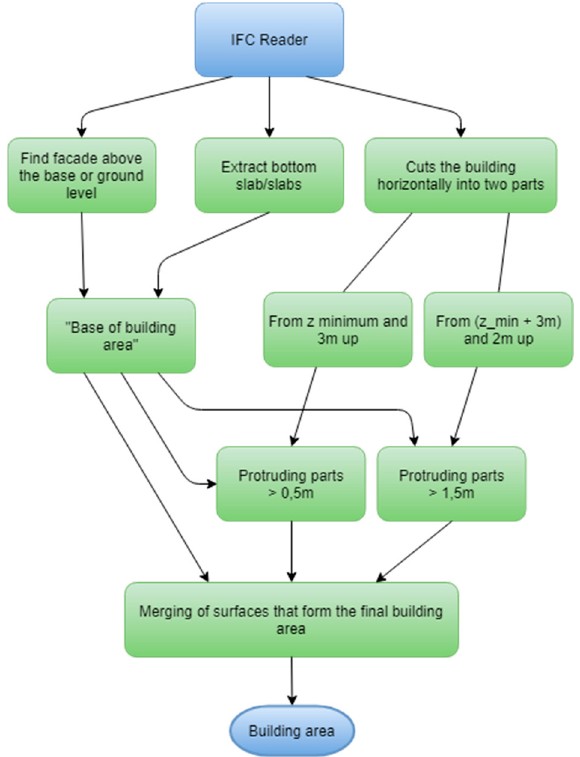
Figure 6. Architecture of the script developed to calculate building area.